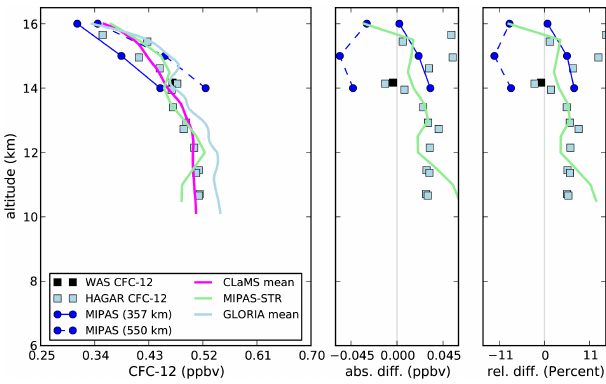
Figure 15. Comparison of CFC-12 abundance between GLORIA dynamics-mode measurements and collocated data